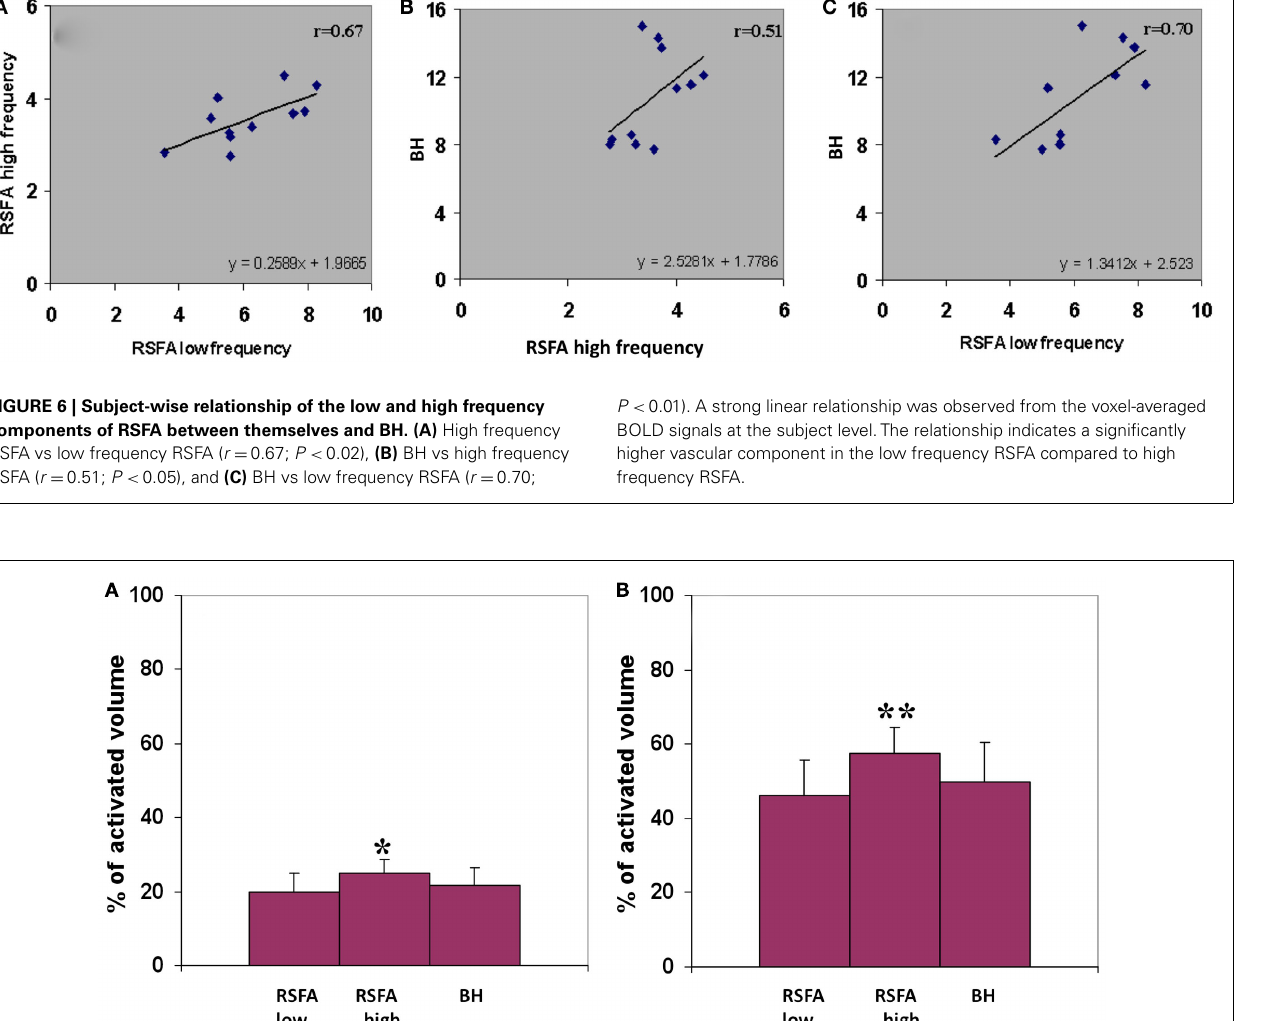
FIGURE 7 | Predicted volume of the motor-task activated ROI with an accuracy of (A) 90% and above, (B) 75% and above. T-fMRI responses across voxels were predicted using the subject-wise R–T relationship in the low and high frequency RSFA derived from the first group of subjects. *Significantly different with respect to low frequency RSFA; paired t -test, P < 0.02. **Significantly different with respect to high frequency RSFA; paired t -test, P < 0.001.